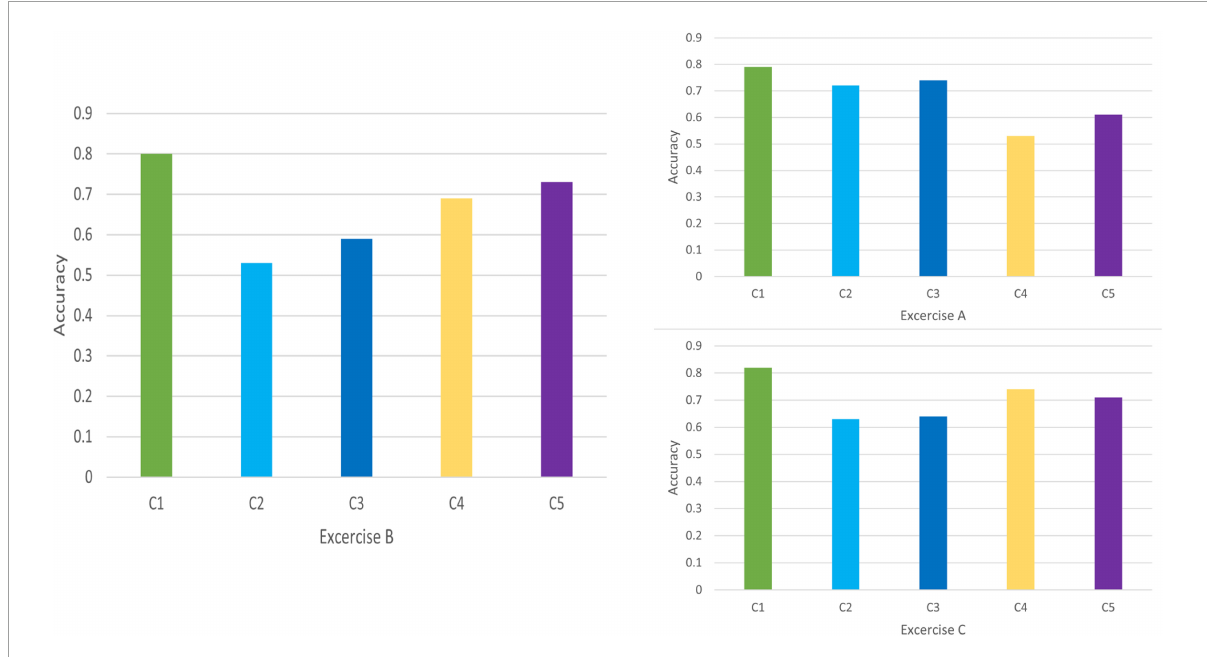
FIGURE7 Feature discrimination results for